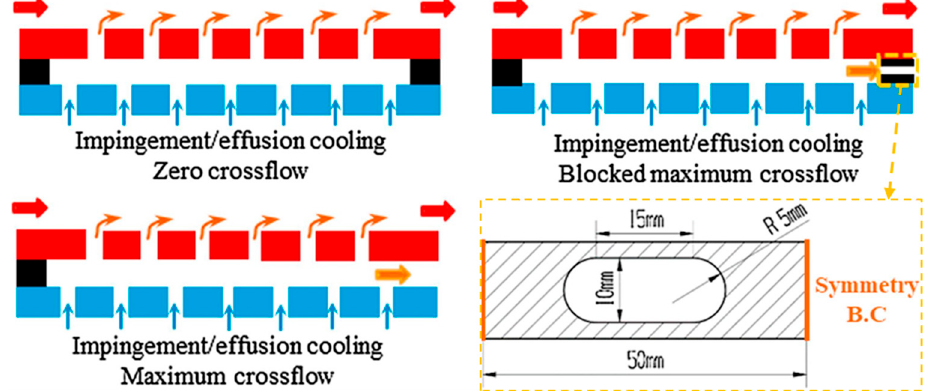
Figure 21. Double-wall cooling configurations with different levels of crossflow. Adapted with permission from [109]. Copyright 2019 Elsevier.